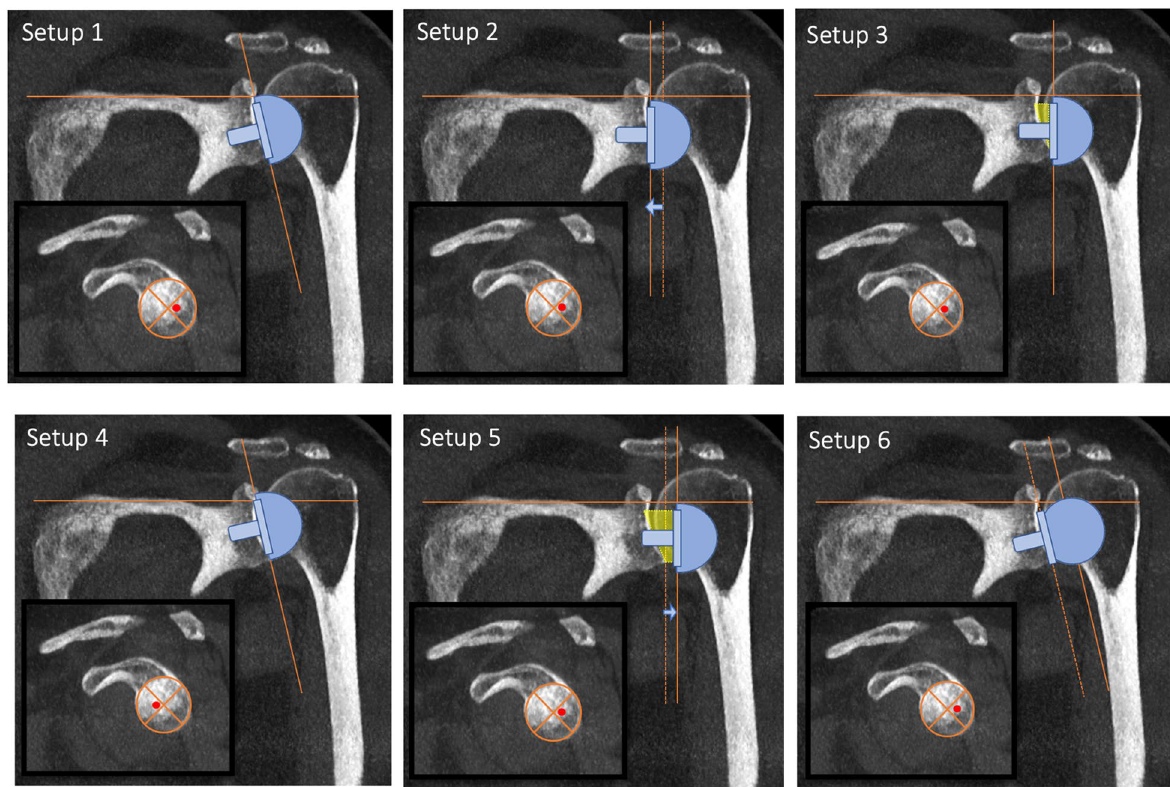
Fig. 2 The different glenoid setups which were tested. The baseline glenoid configuration consisted of a 28 mm baseplate placed flush with the posteroinferior rim of the glenoid and a 36 mm standard glenosphere (Setup 1). Additional configurations with variable baseplate positions, lateralization and inclination were